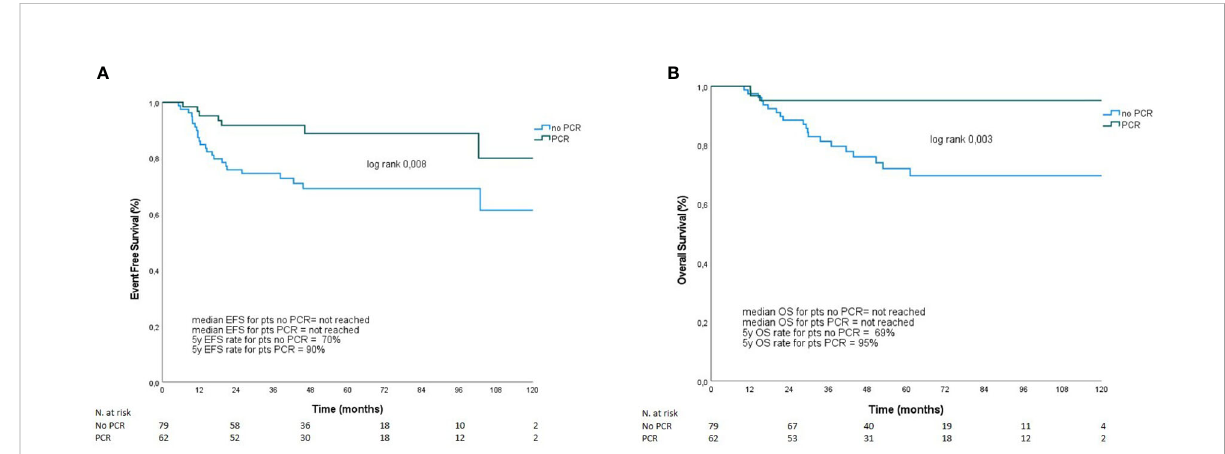
FIGURE 1 EFS (A) and OS (B) according to pCR. Overall survival and presence or absence of relapse was compared between patients with and without pCR after NACT using the Kaplan – Meier method. Survival estimates were calculated and reported at 5 years, along with their 95% con fi dence intervals (95% CI), in pCR and no pCR group. (A) Patients who obtained pCR after NACT showed 5-year EFS 90% vs . 70%, p=0.008. Panel (B) represents 5-year OS in patients with and without pCR (95% vs . 69%,